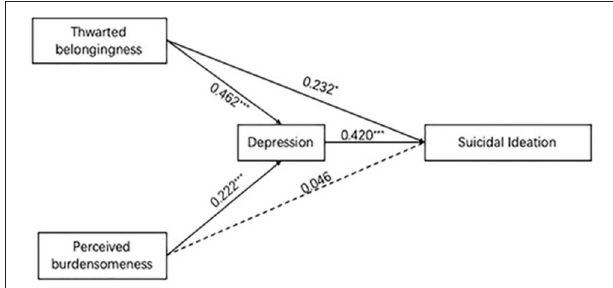
FIGURE 1 | The final model of experiences of thwarted belongingness, perceived burdensomeness, depression, and suicidal ideation among transgender women ( n = 198). All factor loadings were significant at p < 0.05 level. *: p < 0.05; ***: p < 0.001. Age and marital status were adjusted as covariates in the mediation